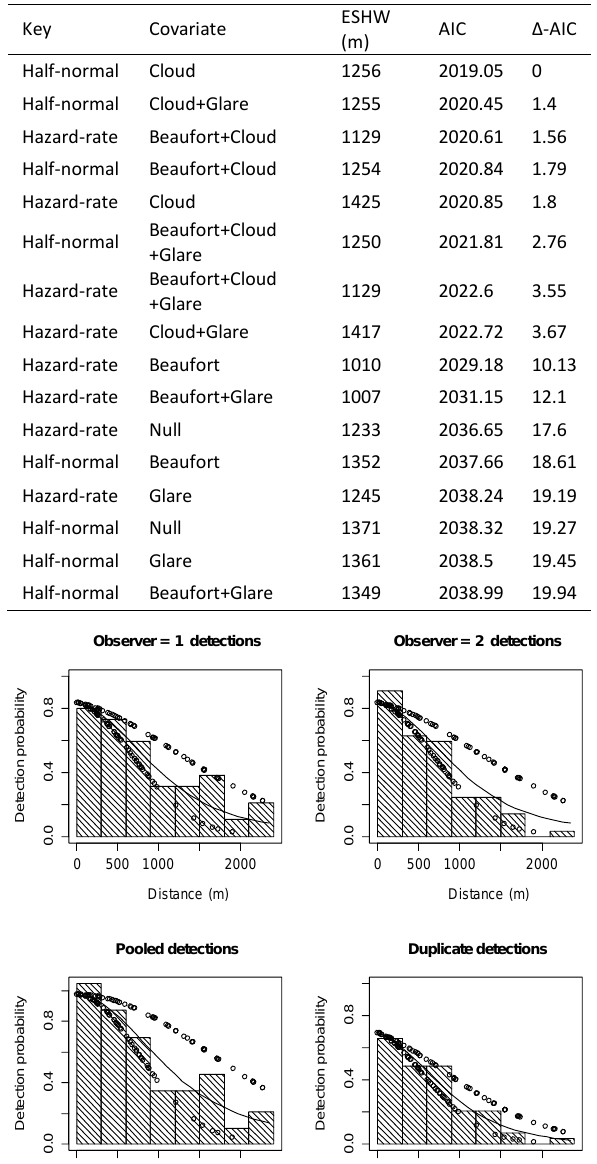
Table 2. Detection function models for MCDS in design-based strata, ranked by Δ -AIC. ESHW: effective strip half-width. "Null" is a model without covariates (i.e., with only perpendicular distance).